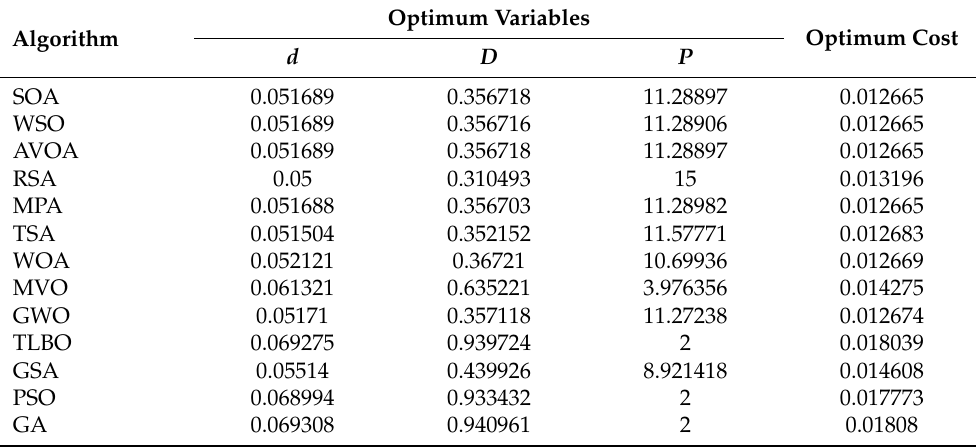
Table 15. Performance of optimization algorithms on the tension/compression spring design problem.